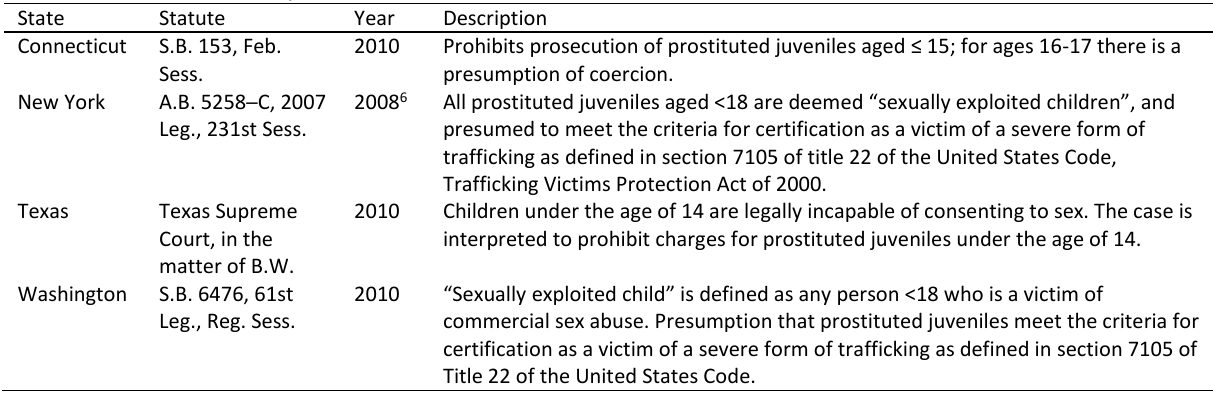
Table 1. Safe Harbor Laws by